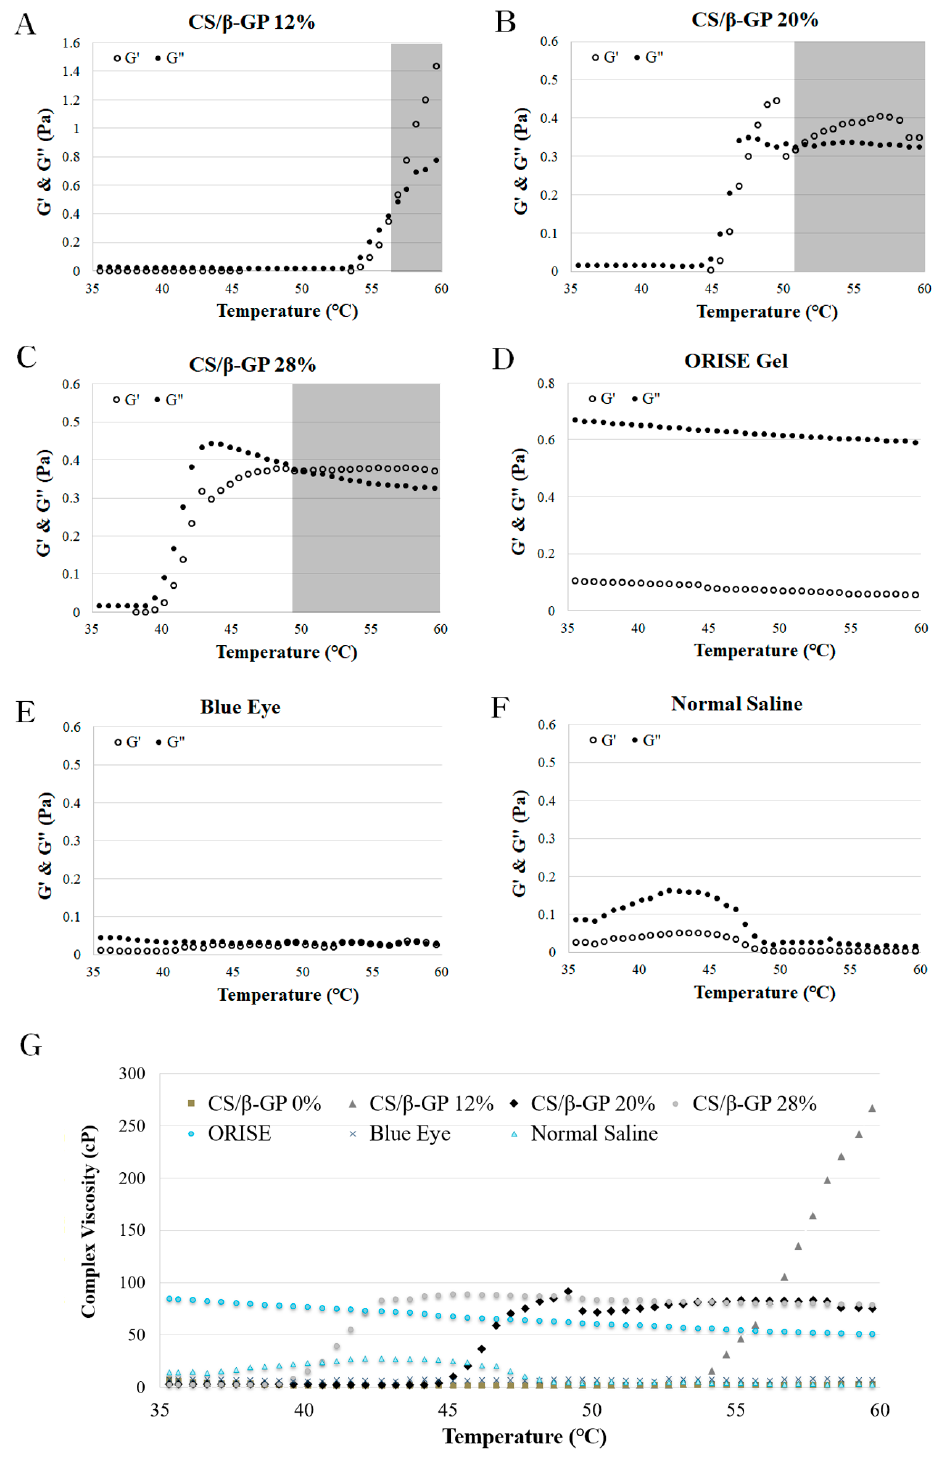
Figure 2. Temperature dependence of the loss modulus (G ″ , ● ) and storage modulus (G ′ , ○ ) of ( A ) CS/ β -GP 12%, ( B ) CS/ β -GP 20% ( C ) CS/ β -GP 28%, ( D ) ORISE™ gel, ( E ) Blue Eye™, and ( F ) normal saline. ( G ) Temperature dependence of the complex viscosity of all samples including CS/ β -GP 0% as a control solution.